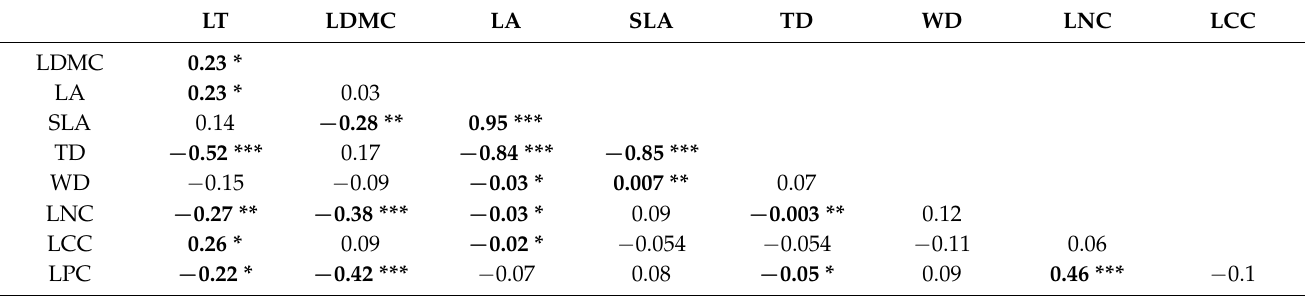
Table 5. Correlation coefficients among leaf functional traits of Quercus aliena var. acutiserrata